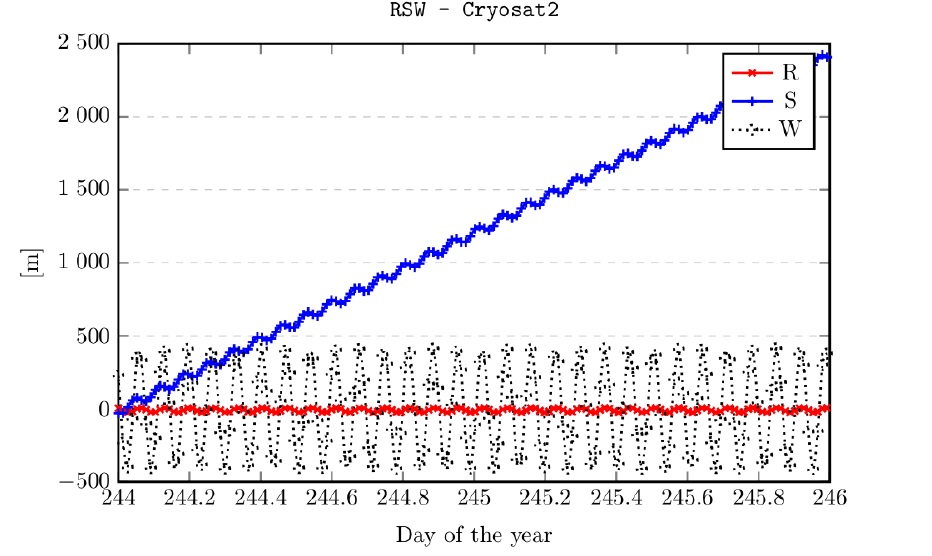
Figure 4. Timeliness of ephemeris data in the orbital object coordinate system (CryoSat-2